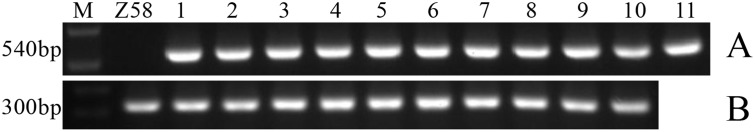
PCR analysis of aga-F75m (A) and actin (B) in the transgenic maize leaves of transformation event 8–1.Lanes: M, the DNA molecular weight markers; Z58, the non-transgenic Zheng58; 1–10, the transgenic plants; 11, the aga-F75 as the positive control.